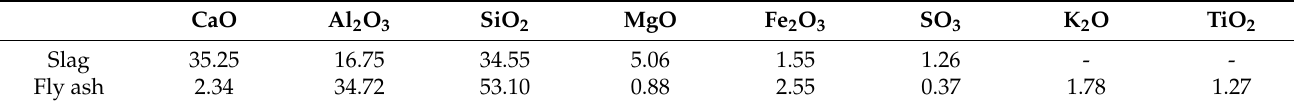
Table 2. Main chemical mineral composition of the geopolymer precursor materials